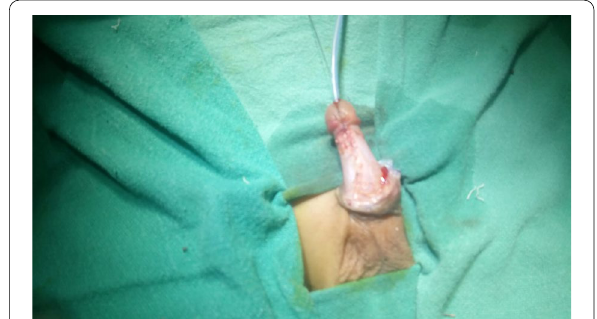
Fig. 8 Subcoronal tightening as witnessed in two